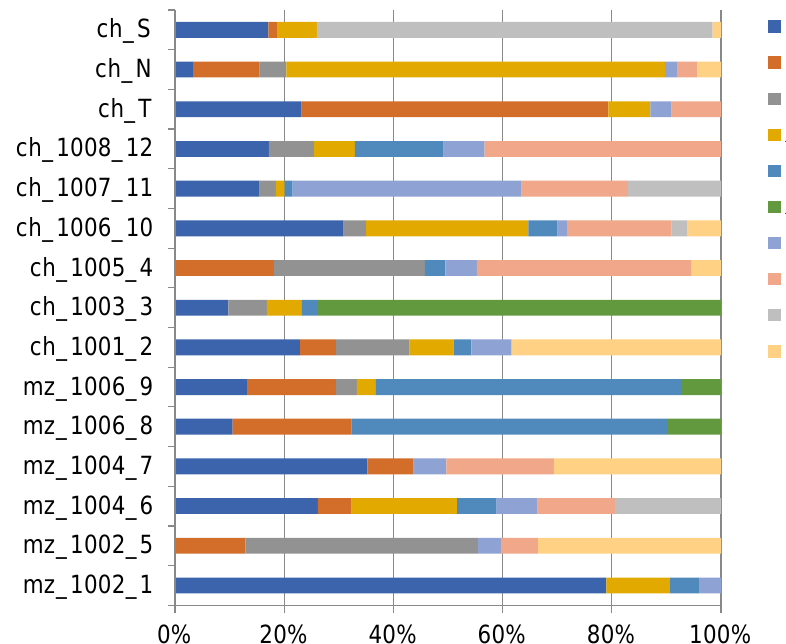
Figure 1. ITS rRNA metabarcoding showing the 10 most abundant operational taxonomic units (OTU) from the study plotted against each soil sample, showing trends in inter-sample relative abundance.